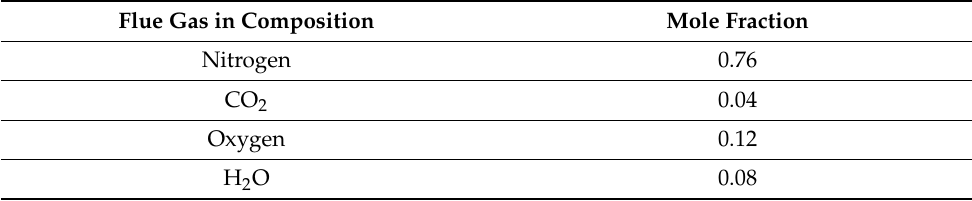
Table 5. Flue gas composition percentages in the simulation model.